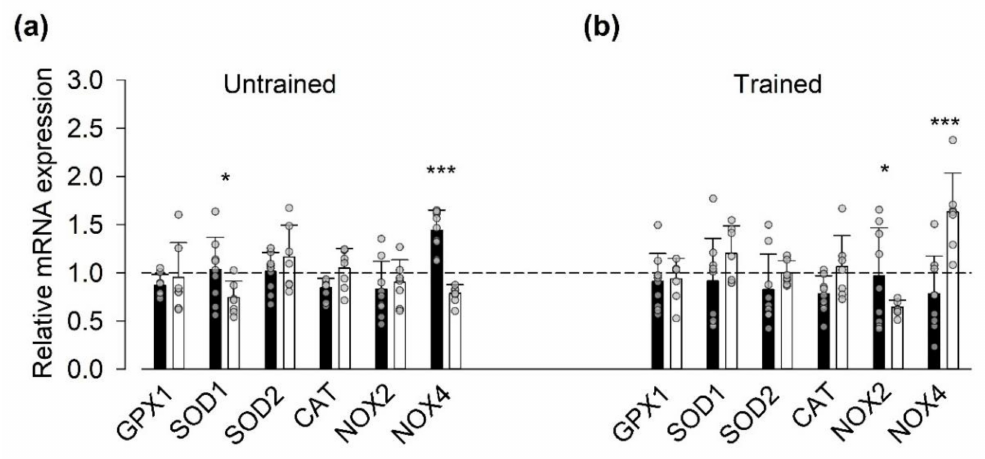
Figure2. Vitamin-treatment-bluntedsprintintervaltraining(SIT)-inducedchangesinmRNAexpression of genes encoding for reactive oxygen / nitrogen species (ROS)-related proteins in the trained state. Data (mean ± SD) are expressed as the ratio of mRNA expression 1 h after to that before the first (( a ), Untrained) and last (( b ), Trained) SIT sessions. Vitamin group (black bars, n = 9); placebo group (white bars, n = 7); dashed line indicates no di ff erence between before and after exercise. Data from each participant are shown as grey circles. Two-way repeated measures ANOVA showed a general group di ff erence ( p < 0.05) in the trained state. Di ff erence between vitamin and placebo groups in relative mRNA expression of individual genes: * p > 0.05, *** p <